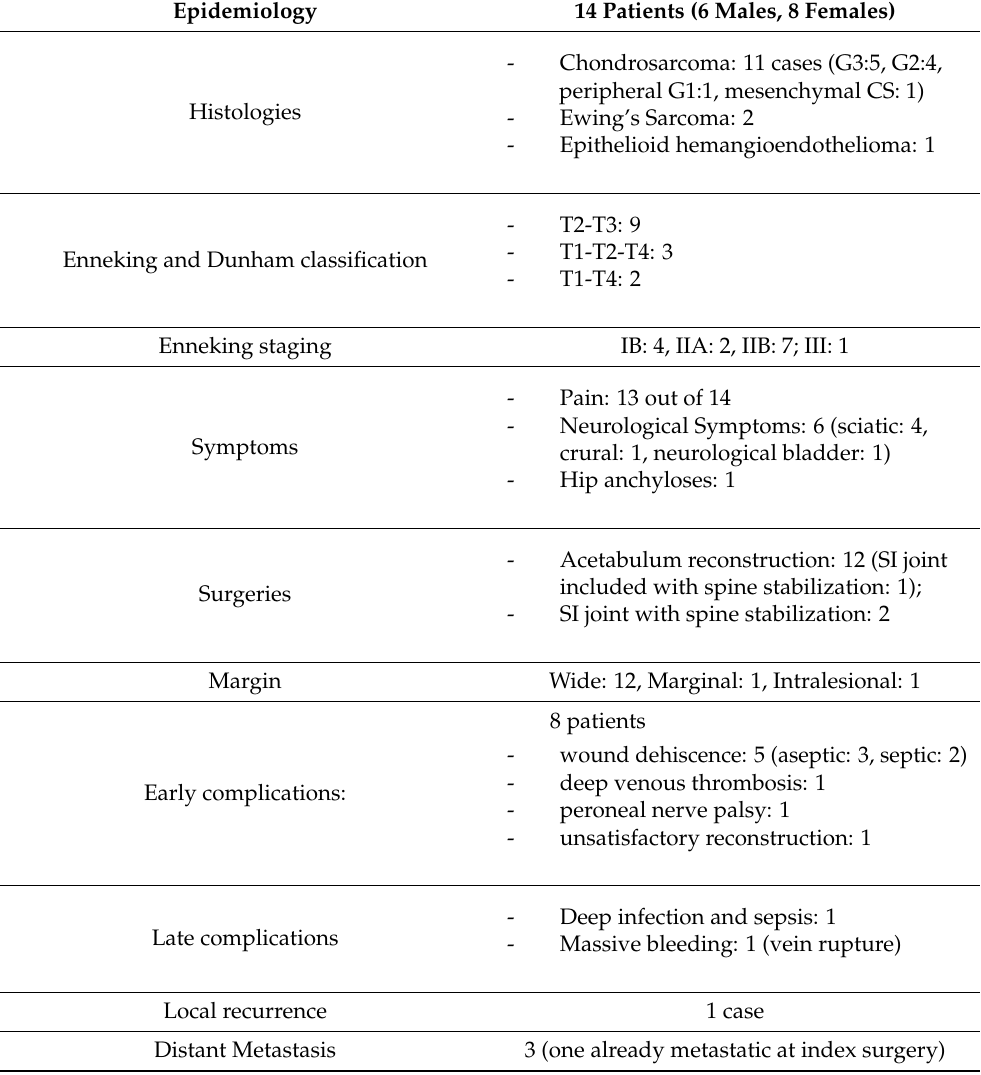
Table 2. Main epidemiology characteristics, histologies, surgery and related